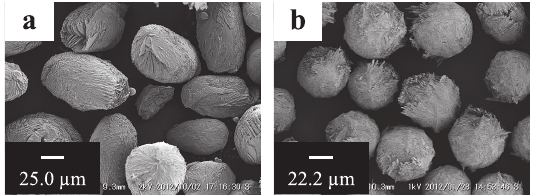
Fig. 4 SEM photographs of alanine and glycine particles during the in- stillation process using an inkjet nozzle: (a) glycine particles using 1-butanol (b) alanine particles using 1-butanol. Reprinted with permis- sion from Ref. (Tamura et al., 2014). Copyright: (2014)